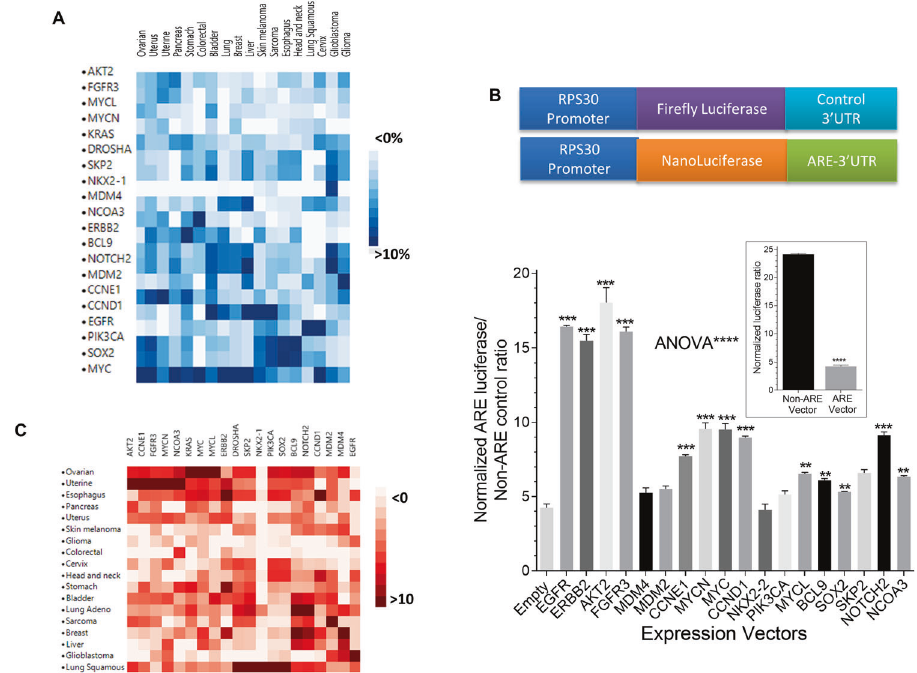
Fig. 1 A screen for post-transcriptional regulation of genes containing AREs elements. A A gene-centric heatmap representing copy number abundance (a minimum of 10% frequency in at least one single type of cancer). Color legend represents % frequency. B HEK293 cells were co-transfected with Super Nanoluciferase reporter vectors containing non-ARE control or RPS30-nLuc-ARE reporter together with of control Fire fl y luciferase vector, for 18 h. Cells were re-seeded into 96-well microplates and were transfected with empty vector control or ERBB2 -HA vector for 18 h. Cells were lysed, and luciferase activity was quantitated as the ratio of Nanoluciferase/Fire fl y luciferase intensity. The screen is at least from two independent experiments with Mean ± SEM of triplicate readings. ANOVA with Dunnett ’ s multiple comparisons was used to compare the effects of each of the indicated vectors and the empty vector on ARE-reporter readings. ** p < 0.01, *** p < 0.001, **** p < 0.0001. C Cancer-centric heatmap representing clustering of cancer type according to copy number